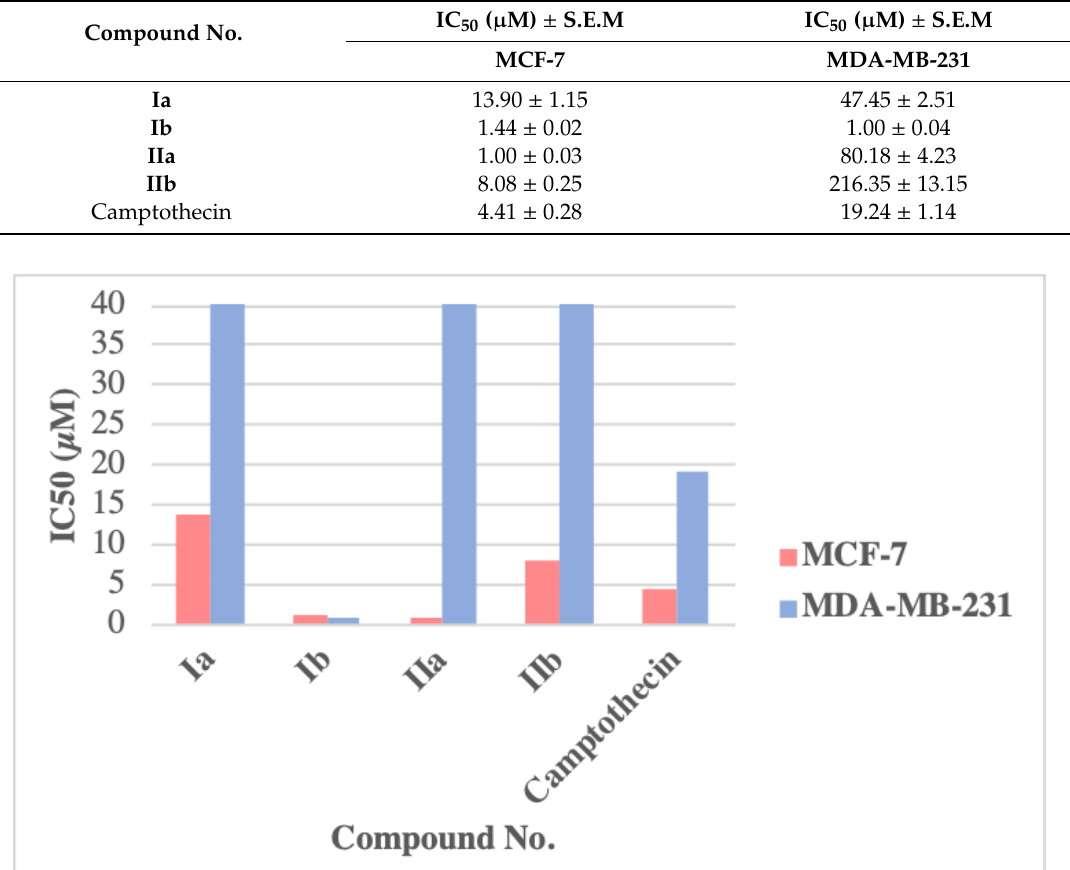
Table 2. Cytotoxicity of the synthesized N-substituted coumarin-4-acetamides IIIa – h and camptothecin.